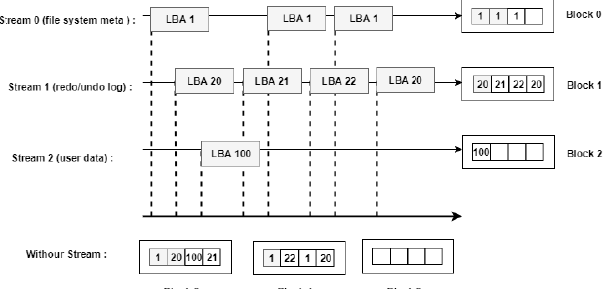
Figure 3. Multi-streamed eMMC writes data into a related NAND block according to stream ID regardless of LBA. Three streams are introduced to store different types of host system data